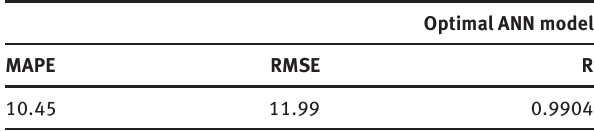
Table 8 Performance criteria of ANN model.